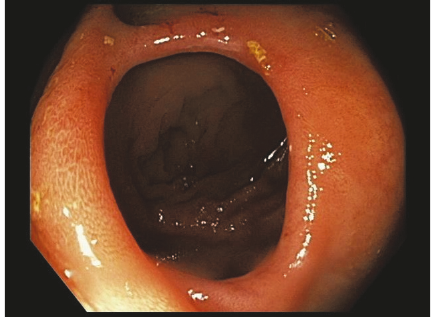
Figure 1: Endoscopic view of the ascending colon demonstrating a diaphragm-like stricture with scarring and ulceration.